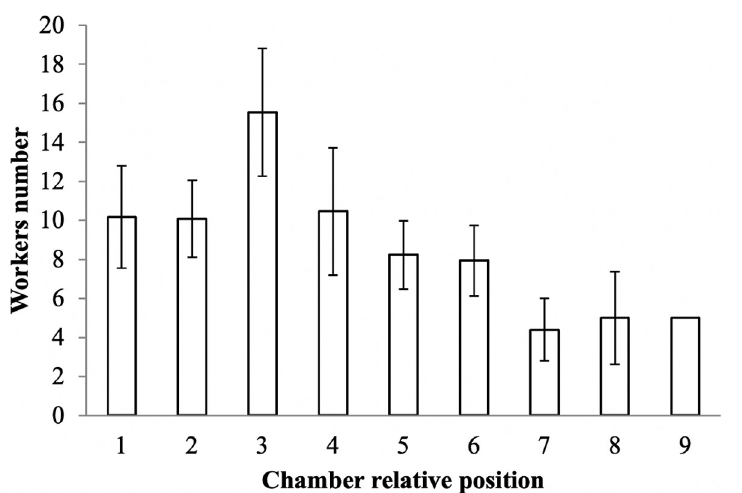
Fig 4. Mean ( ± SEM) of E . ruidum sp. 2 workers per chamber in the 24 nests collected using the paraffin wax technique. See Table 1 for the sample size and the depth corresponding to each chamber’s relative position.